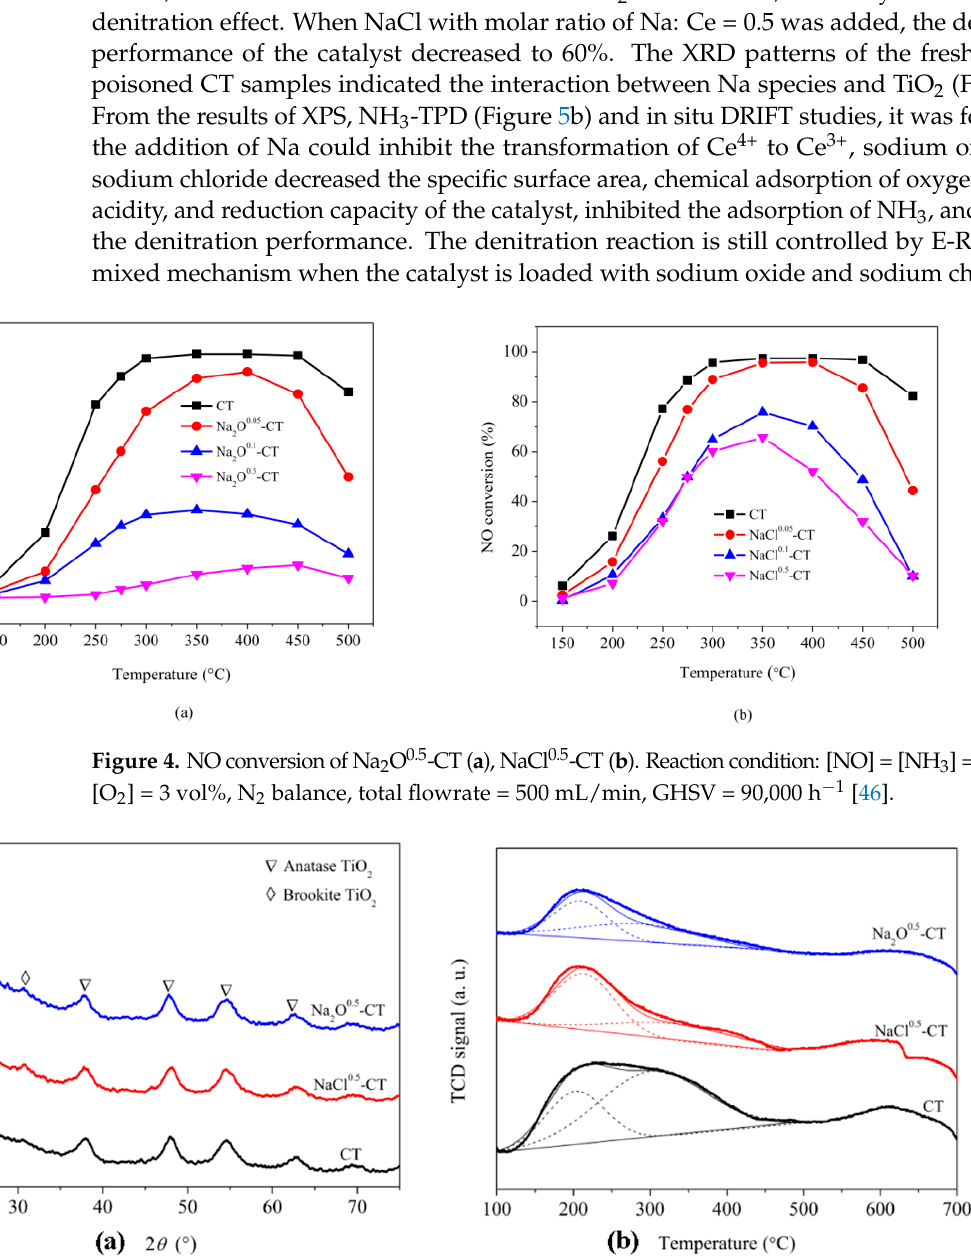
Figure 5. ( a ) XRD patterns of CT, Na 2 O 0.5 -CT, and NaCl 0.5 -CT catalysts; ( b ) NH 3 -TPD profiles of CT, Na 2 O 0.5 -CT, and NaCl 0.5 -CT catalysts [46].